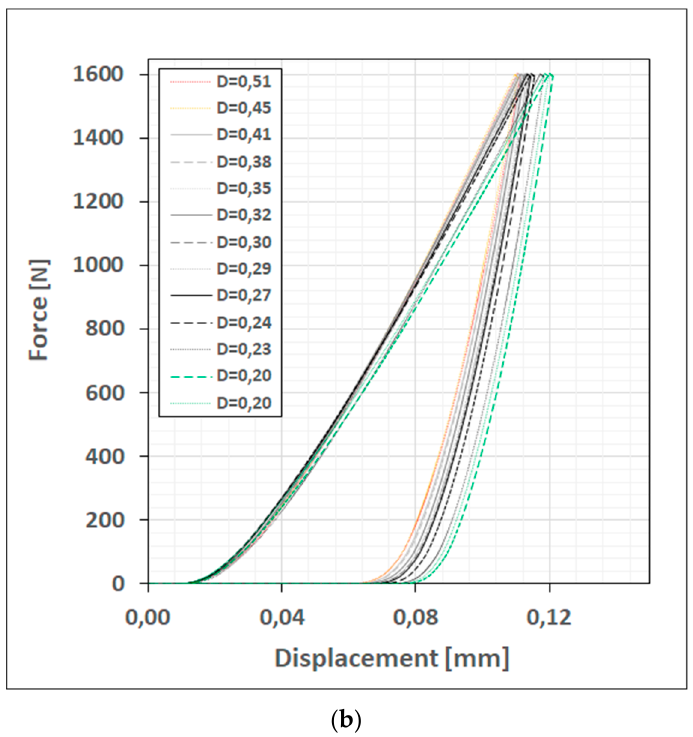
Figure 9. Specimen after static tension test: ( a ) gage part of the specimen after indentation tests; ( b ) and indentation force–displacement plots.